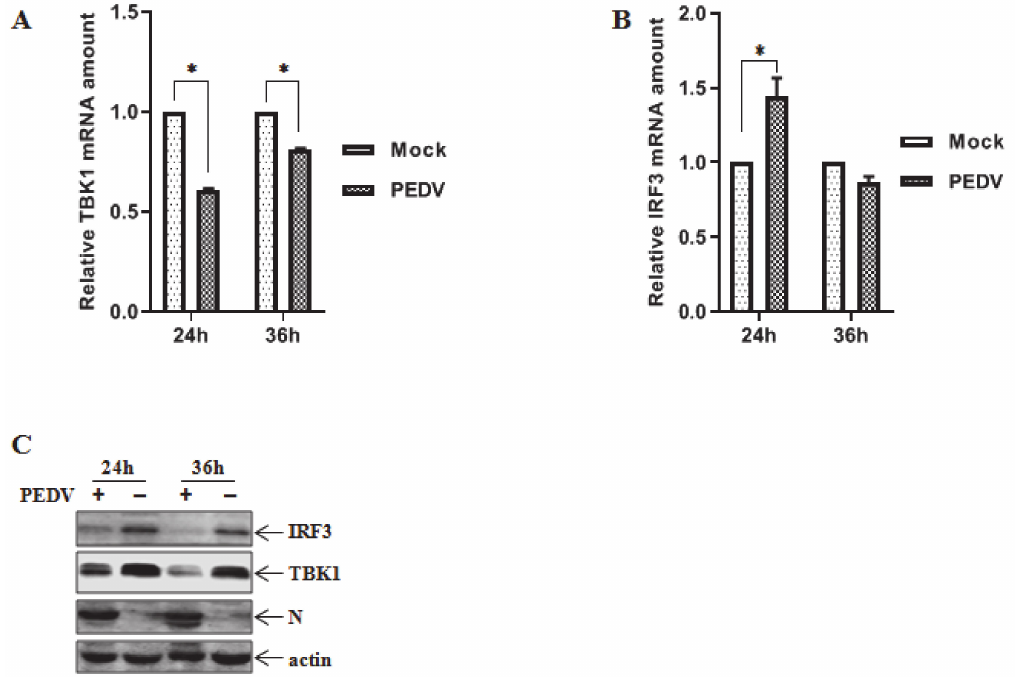
Figure 1. PEDV infection reduces TBK1 and IRF3 expression. ( A , B ) IPEC-J2 cells were infected with PEDV at MOI of 1.0 for 24 h and 36 h. Total RNA was extracted from cell samples and TBK1 and IRF3 mRNA levels were assessed by quantitative RT-PCR using the primers listed in Table 1. Three independent experiments were performed in triplicate, and values are the means ± SD for all three experiments. *, p < 0.05. ( C ) HEK293 cells were inoculated with PEDV at MOI of 0.1 for 24 h and 36 h followed by verification of endogenous TBK1 and IRF3 proteins by western blot